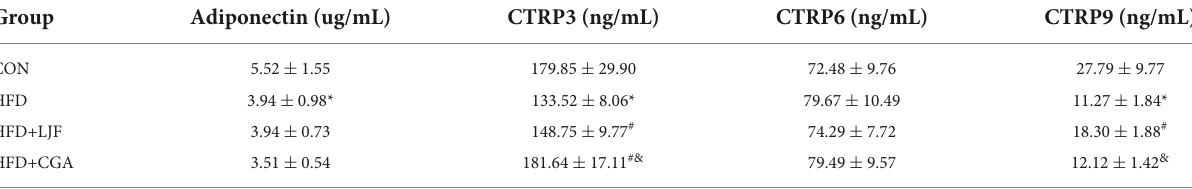
TABLE 2 Lonicerae Japonicae Flos and CGA improved serum adipokine disorder.